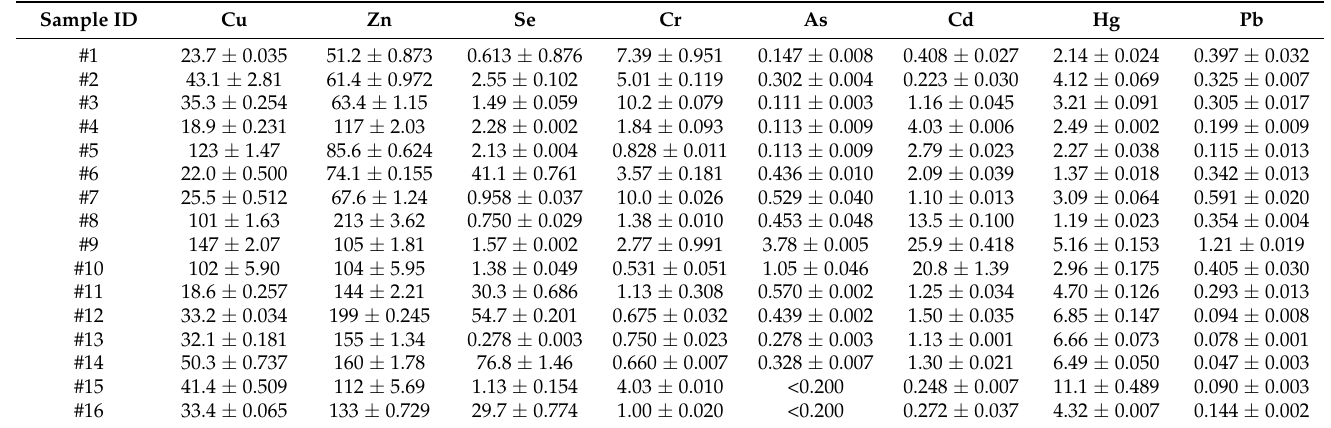
Table 3. Metallic elements and metalloid concentrations (mg kg − 1 DW) in the analyzed wild edible mushroom species from southern Spain and northern